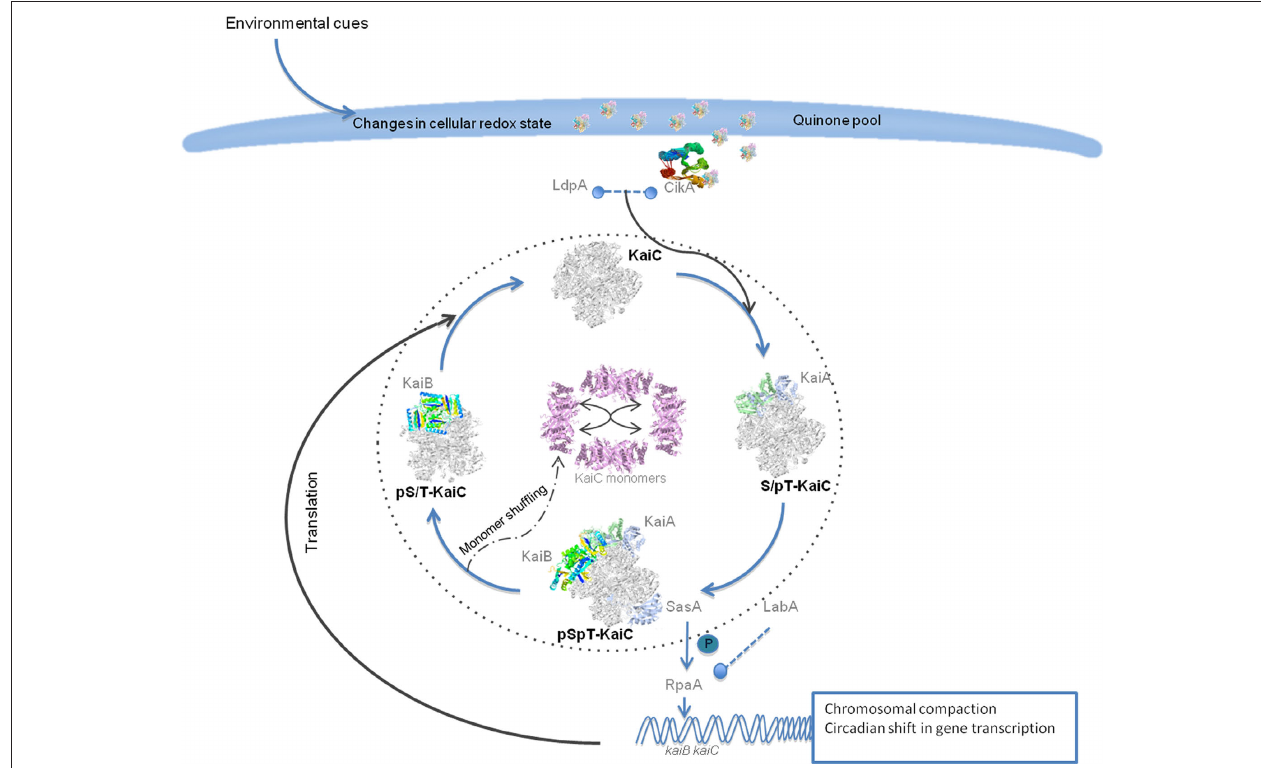
Figure 1 | Schema of the molecular mechanisms of the circadian clock in S. elongatus. The input pathway responds to the environmental signals like light and temperature to entrain the circadian oscillator. Both CikA and LdpA can sense changes in the redox state of the cell. CikA interacts with quinones through its pseudo receiver domain. The components of the input pathway influence the phosphorylation state of the KaiC hexameric complex. The KaiA homodimer complex binds to KaiC and stimulates its phosphorylation. KaiC is first autophosphorylated at the T432 conserved residue and reaches the highest phosphorylation state when on each KaiC monomer the T321 and S431 residues